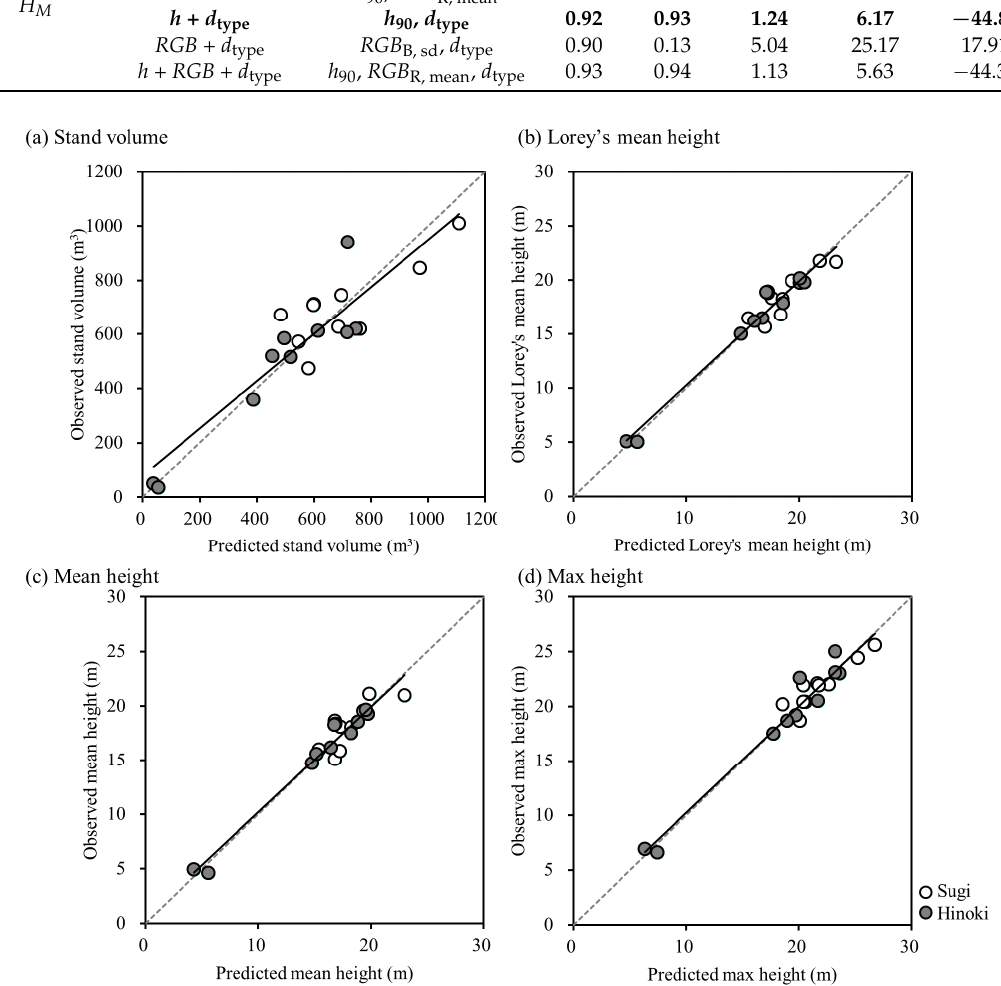
Figure 2. Observed biophysical properties versus predicted biophysical properties from the best model of each of the canopy height models. A diagonal dotted line and a solid line indicate the 1:1 line and regression line between the predicted biophysical properties and observed biophysical properties, respectively.